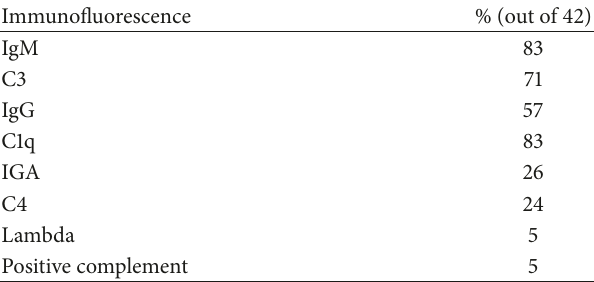
Table 6: Renal biopsy immunofluorescence findings.